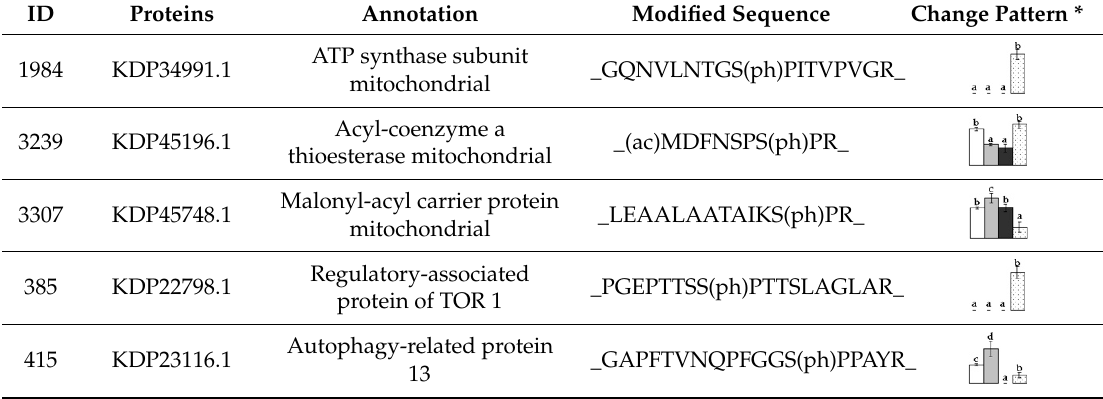
lowercase letters labeled above columns indicate significant changes according to one-way ANOVA ( p < 0.05).